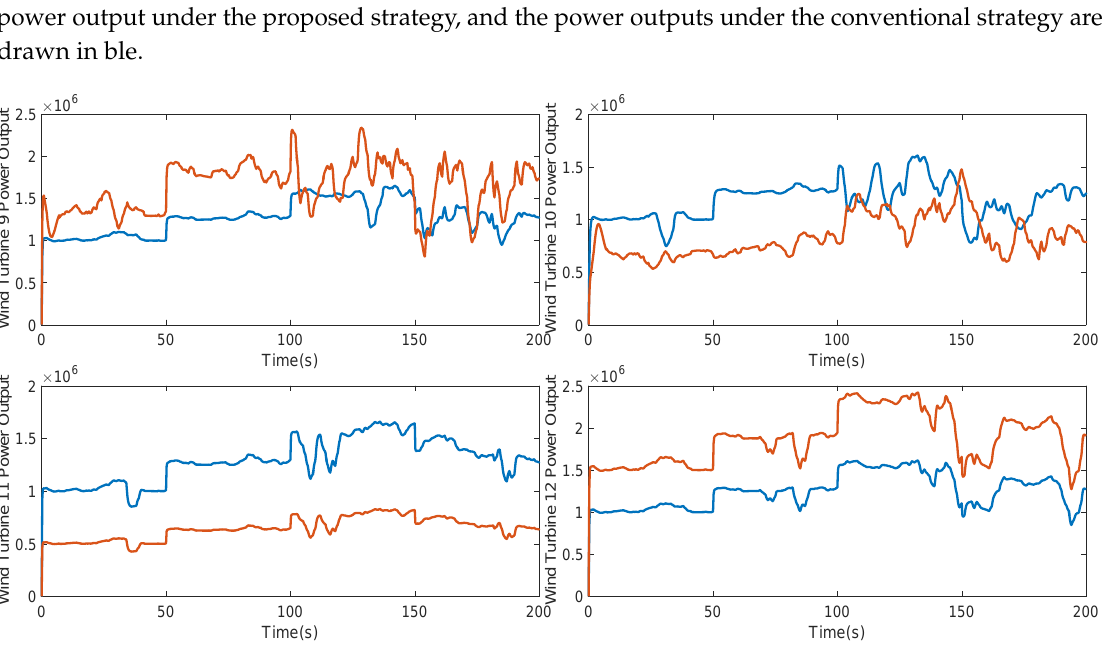
Figure 7. Cluster 3 units power output